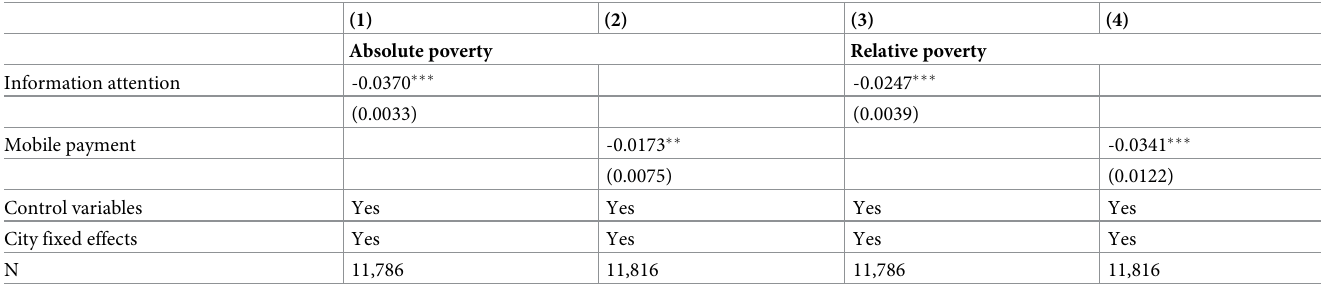
Table 7. Information constraints and rural household